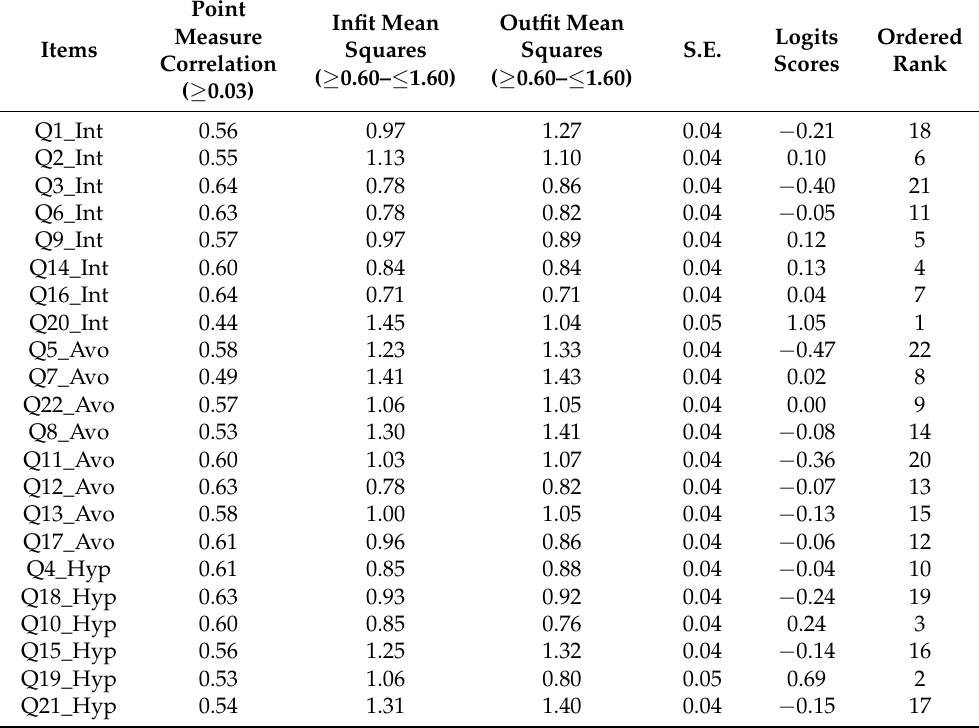
Table 4. Rasch parameters of the Impact of Event Scale-Revised